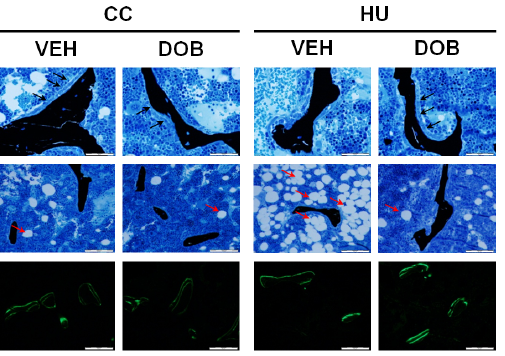
Figure 4. Effects of dobutamine (DOB) or vehicle (VEH) administration during hindlimb unloading (HU) or ambulatory cage activity (CC) on cancellous bone bone cell activity and marrow adipocyte proliferation. ( Top Row ) Representative micro- graphs of osteoblasts (von Kossa and tetrachrome stain; 6 400 magnification), ( Middle Row ) marrow adipocytes (x200 magnification), and ( Bottom Row ) fluorochrome labeling (calcein, 200 6 ) on the surface of cancellous bone at the distal femur. Note the increased number of osteoblasts ( black arrows, top row ) and greater osteoid surface ( below osteoblasts ) in the HU + DOB group vs. HU + VEH. Also, note the increased number of marrow adipocytes ( red arrows, middle row ) in the HU + VEH group. The increased number of osteoblasts noted in the von Kossa and tetrachrome stained slides from HU + DOB samples correlated with extensive flurochrome labeling and large interlabel width ( bottom row ).